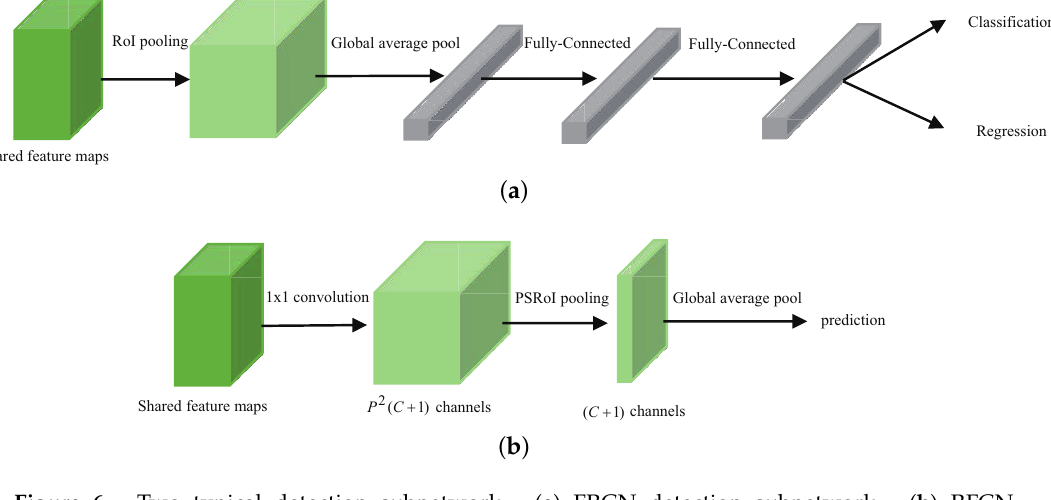
Figure 6. Two typical detection subnetwork. ( a ) FRCN detection subnetwork. ( b ) RFCN detection